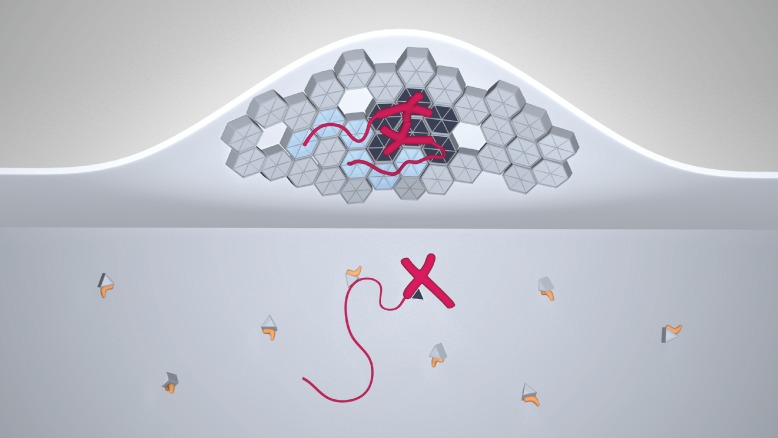
A model for selective HIV-1 genome packaging.Cytosolic Gag (light gray triangles) is inhibited from membrane association by its association with tRNA (yellow). Gag (triangles and hexagons, colored dark gray where forming specific contacts with the packaging signal) binding viral genomic RNA (red; thick portions correspond to the 5’UTR, thin portions to the remainder, not shown to scale) has a higher probability to overcome this inhibition and associate with the plasma membrane. The selectivity of membrane-bound Gag for the viral genome necessitates CA-CA immature lattice contacts.